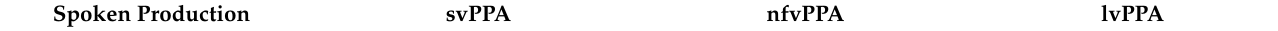
Table 1. Underlying cognitive deficits and salient characteristics of spoken production disorders in the three PPA variants. Spoken